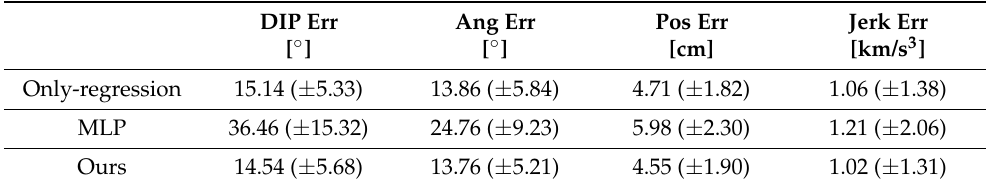
Table 2. Evaluation of the attention network and regression network for pose estimation on the DIP-IMU dataset. The evaluation is conducted by DIP, Angle, Position, and Jerk error metrics. The results of “Only-regression” and “MLP” are based on the settings described in the ablation study. DIP Err [ ◦ ]